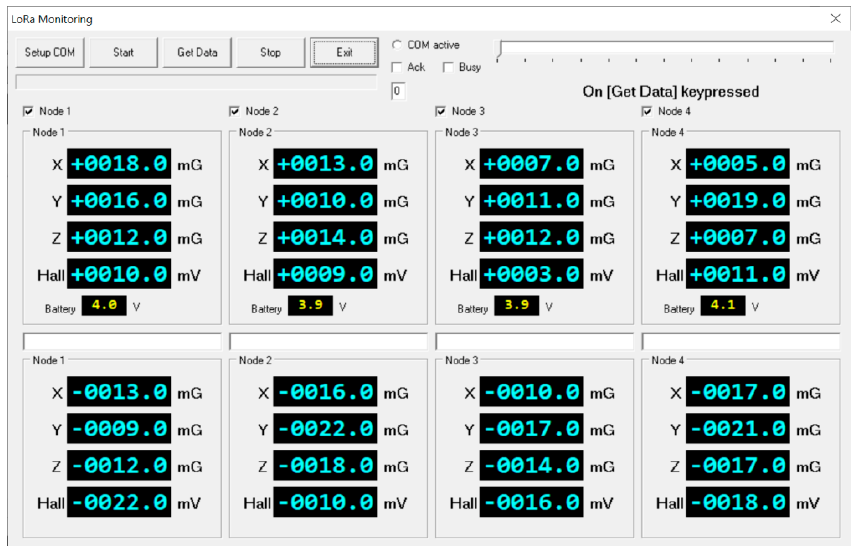
Figure 4. Sensing node: ( a ) Hall-effect sensor configuration; ( b ) Node schematic diagram (red arrows—power lines, blue arrows—data lines, green arrows—analog signal lines).